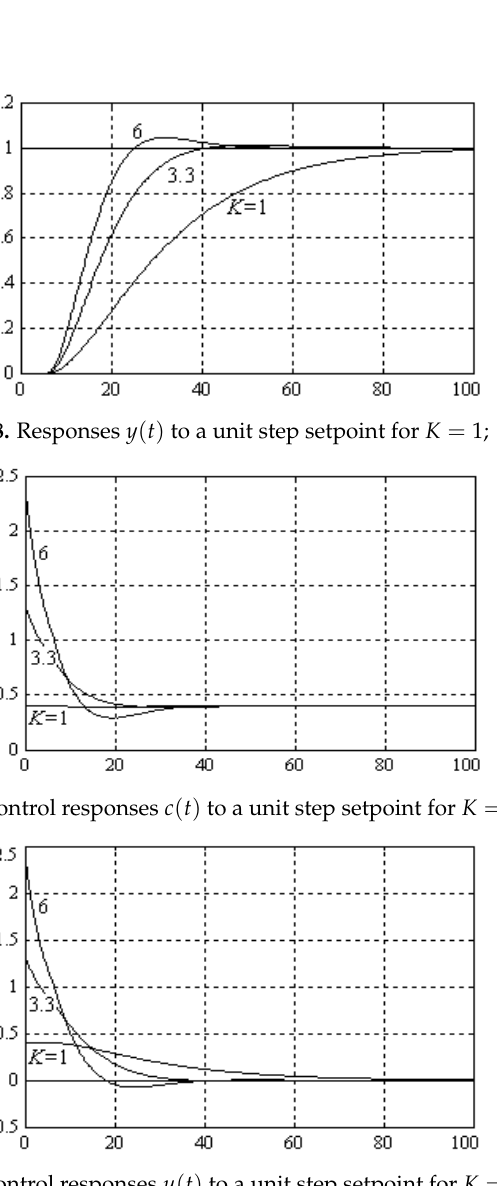
Figure 30. Control responses u ( t ) to a unit step setpoint for K = 1; 3.3; 6.